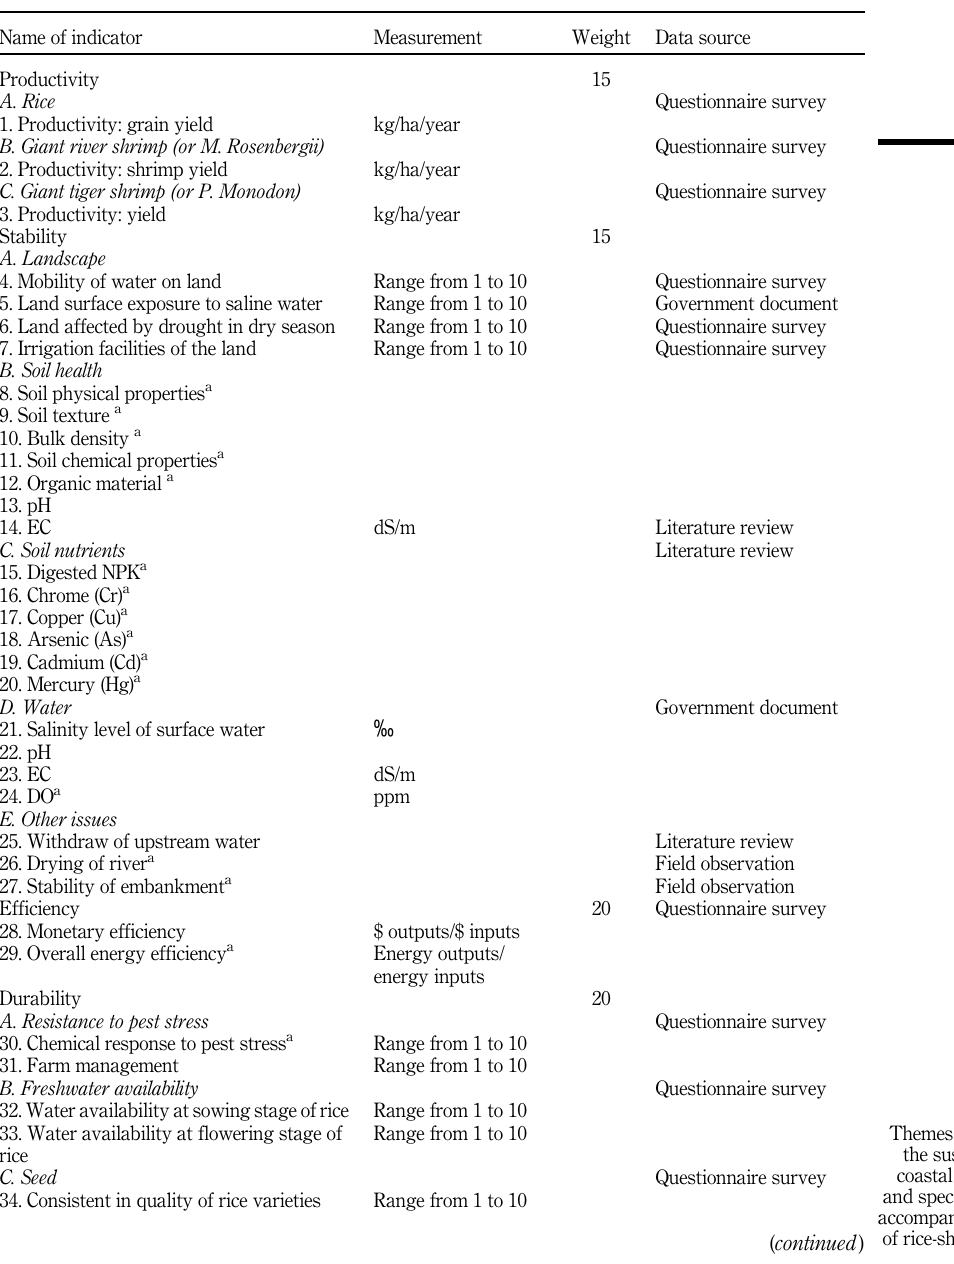
Table AII. Themes for